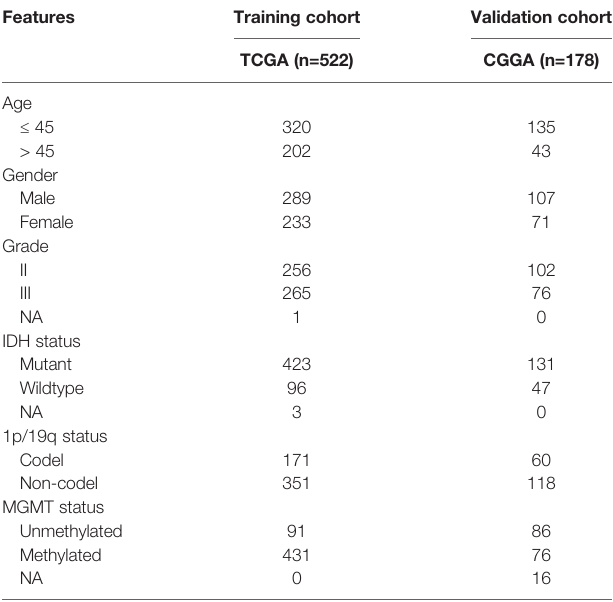
TABLE 1 | Characteristics of the training cohort and validation